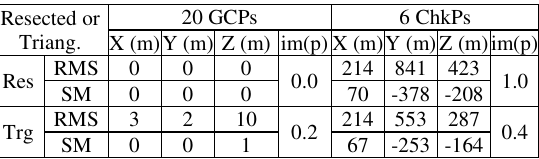
Table 4. RPC Errors at GCPs and ChkPs